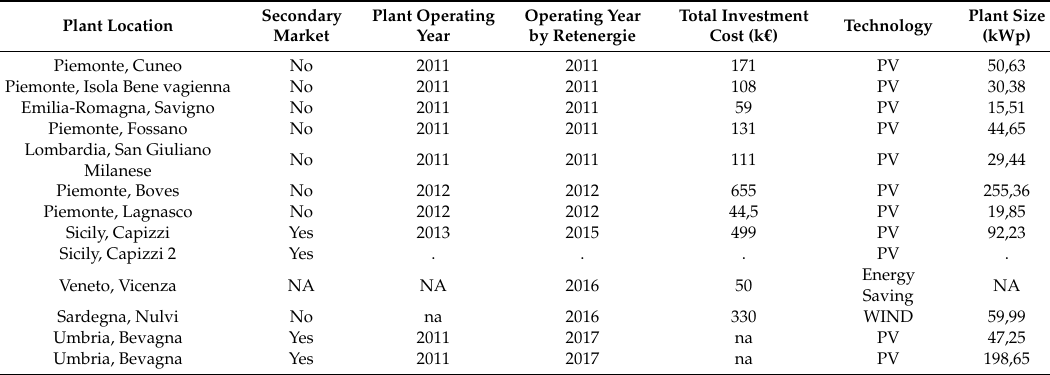
Table 1. Projects developed by Retenergie.